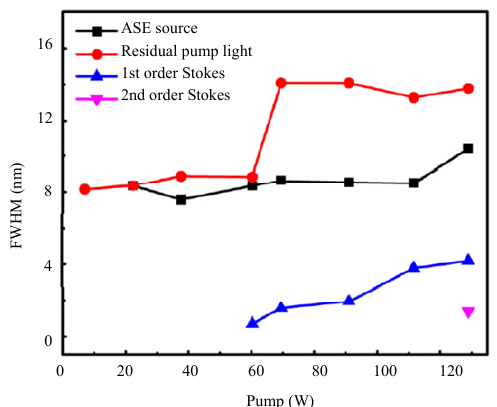
Fig. 3 Linewidth variation of the ASE source, residual pump light, and 1st and 2nd order Stokes lights as a function of the ASE pump